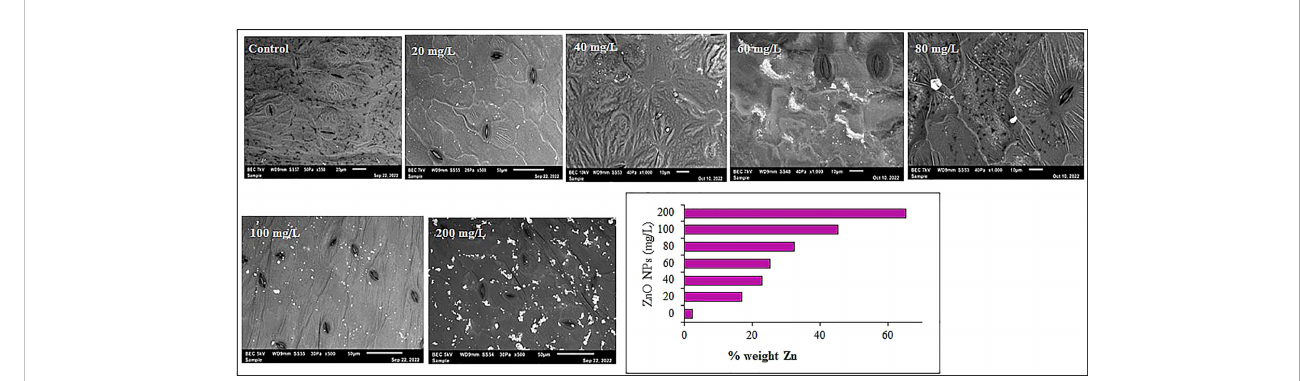
FIGURE 9 SEM analysis showing Zn accumulation in mustard leaves from plants treated with different ZnO NPs concentrations. The bar plot from EDX shows the percent weight of Zn detected from each